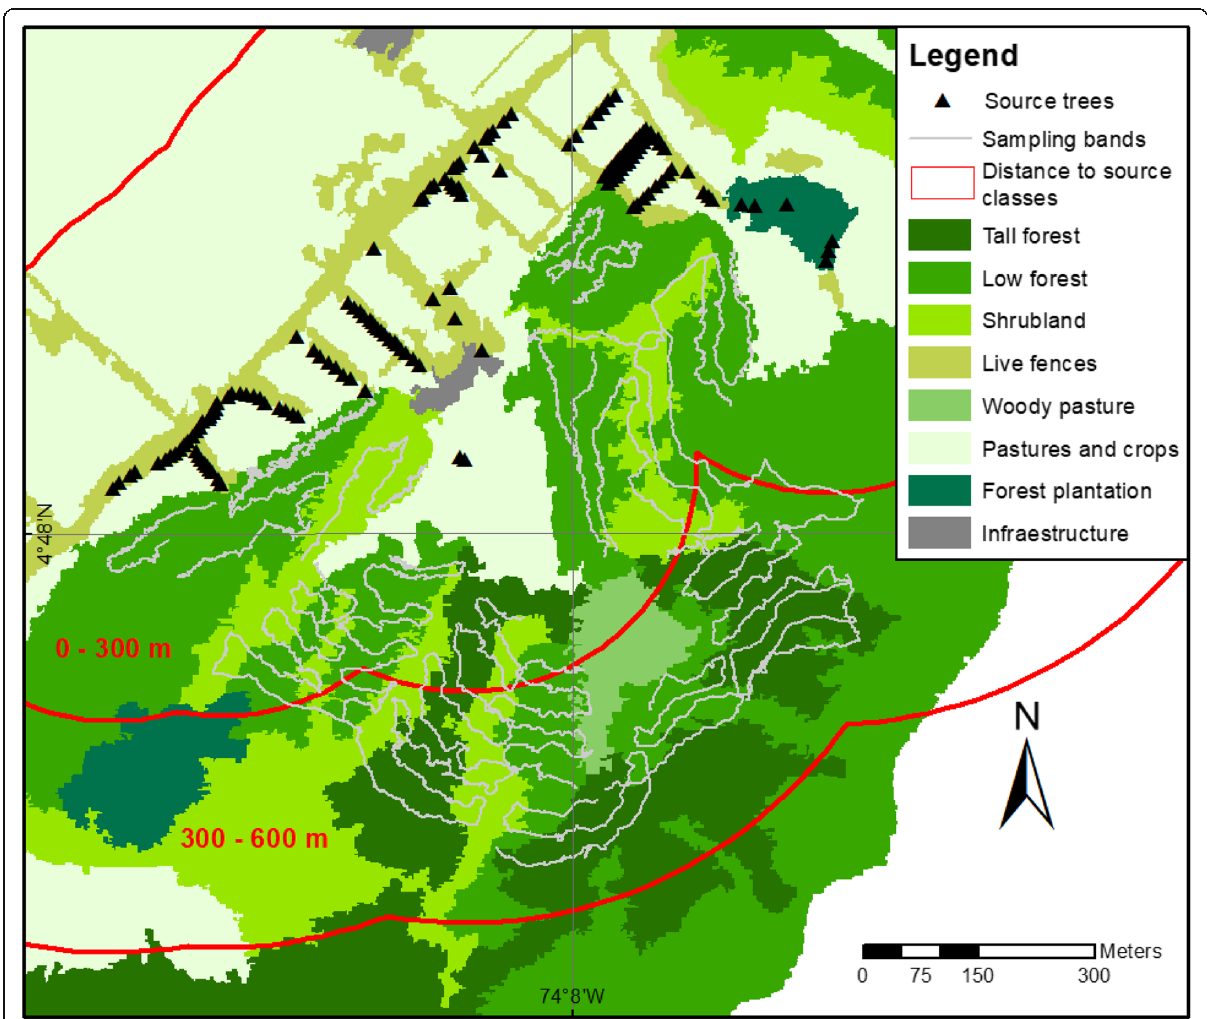
Fig. 2 Land cover map and distance classes. Black triangles represent seed source trees of Fraxinus uhdei . Distance classes were calculated around the seed source trees (red